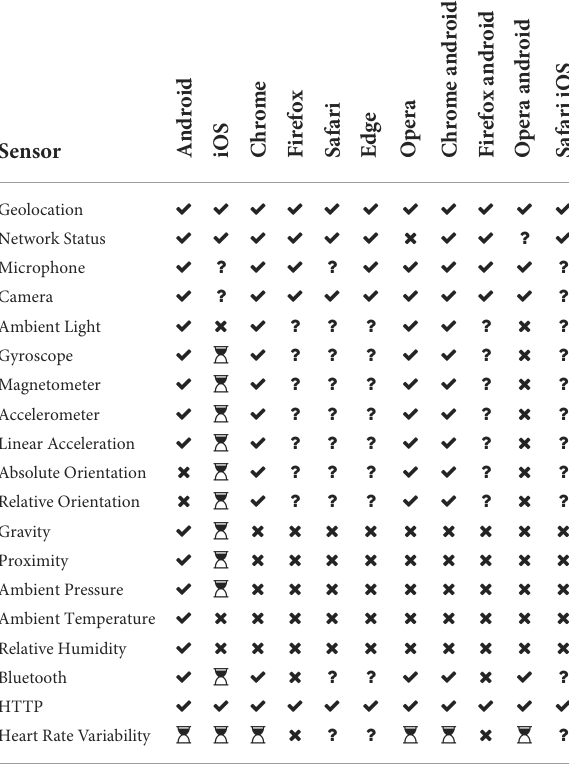
Table 2 Availability for predefined sensor implementations on different